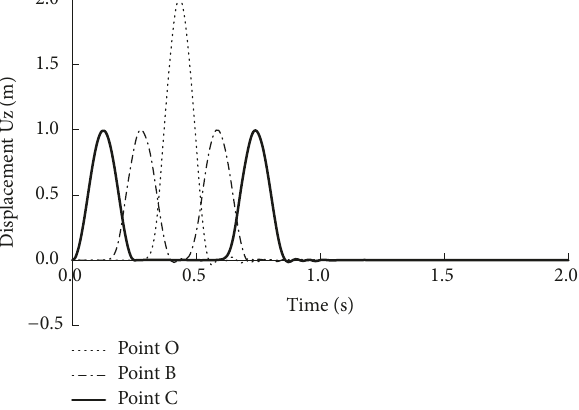
Figure 7: Theory displacement.